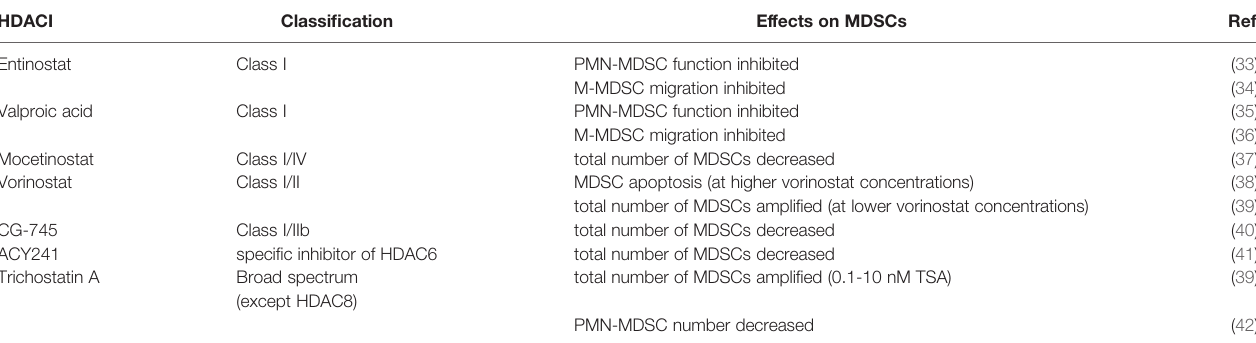
TABLE 1 | Effects of HDACIs on